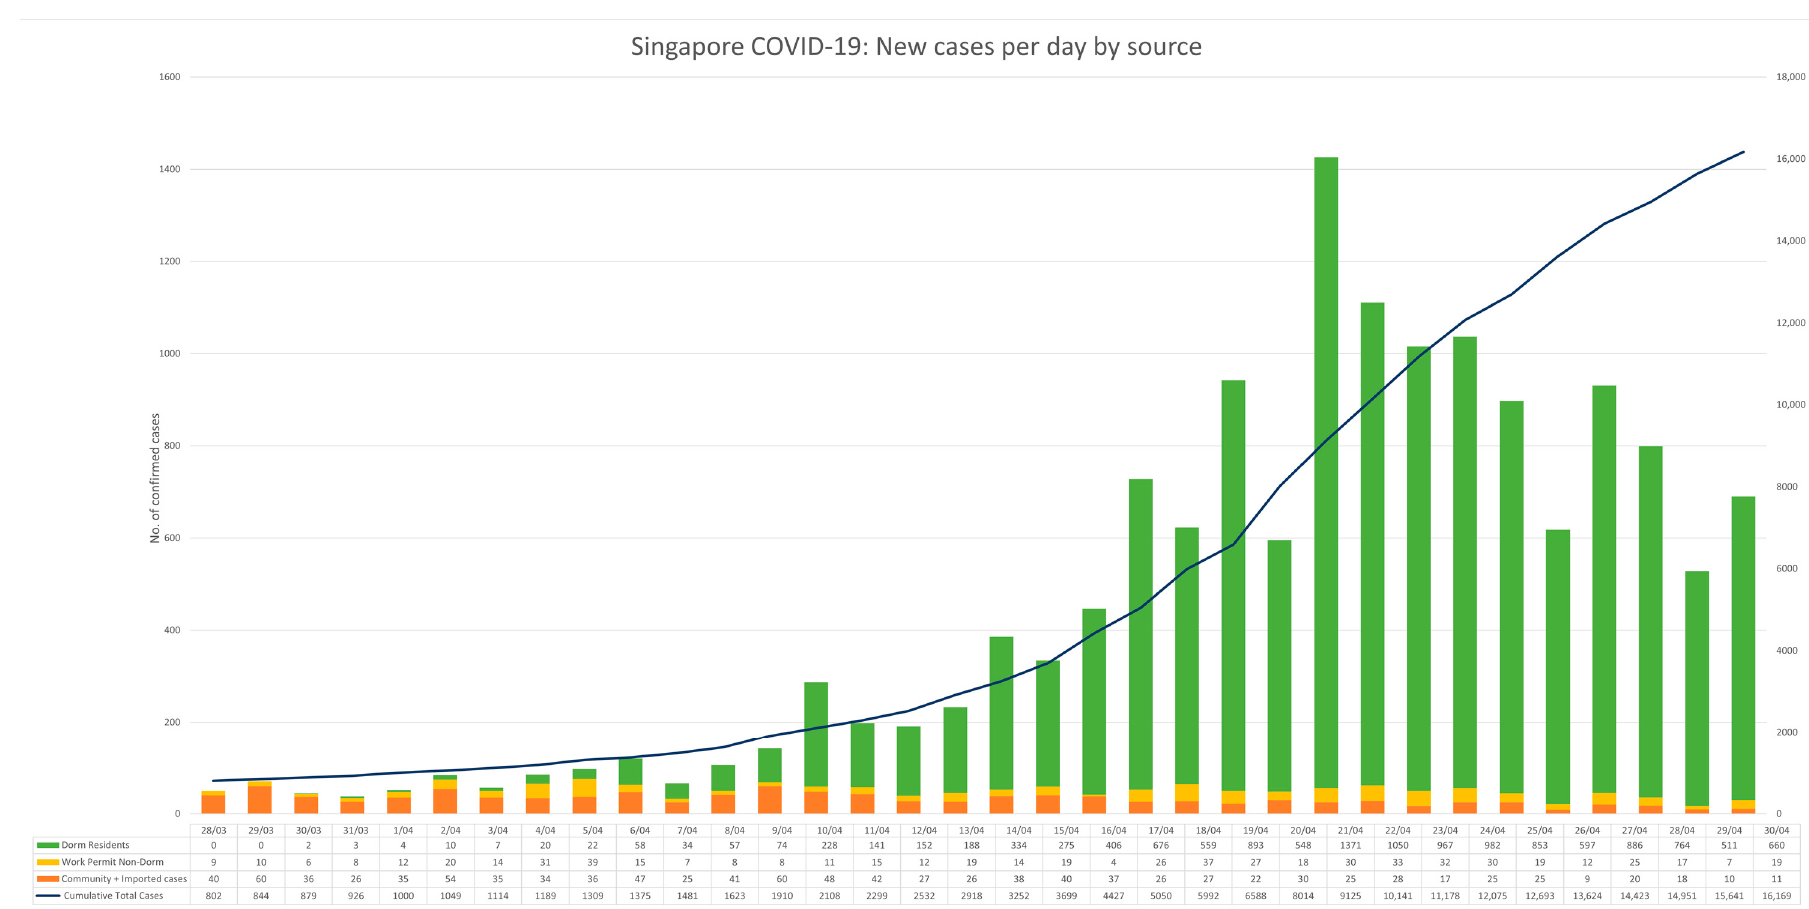
Figure 1. Confirmed cases reported between 27 March–1 May 2020. Source. https://www.moh.gov.sg/covid-19/situation-report. Local Community includes residents, pass holders and work permit holders (WPH) not residing in dormitories.